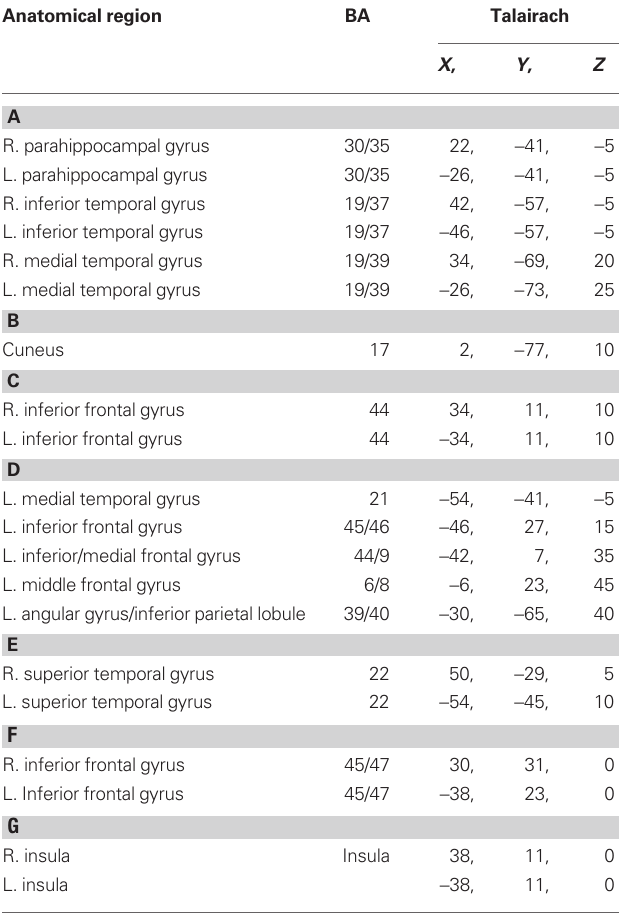
Table 2 | Activation foci (Talairach coordinates) for the ICA components displayed in Figure